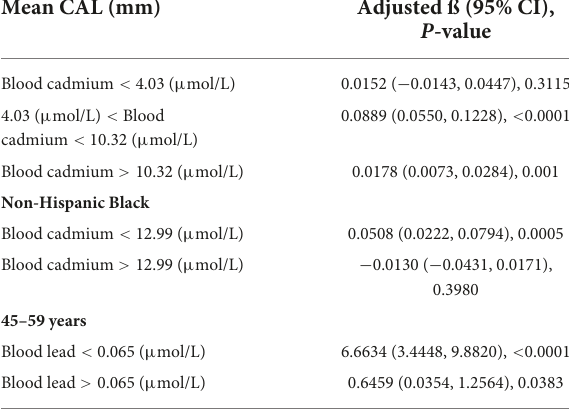
TABLE 7 Threshold effect and saturation effect analysis of blood cadmium and blood lead on mean